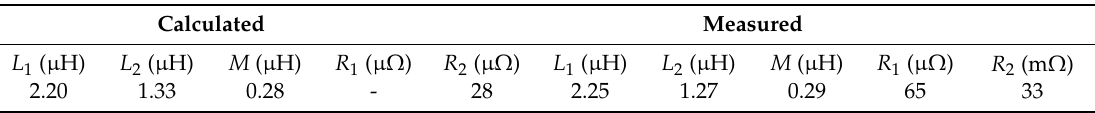
Figure 12. Setup for the measurement of the coil circuit parameters. Table 1. Calculated and measured circuit lumped parameters for the primary coil with N 1 = 1 and for the secondary coil / landing gear with N 2 =